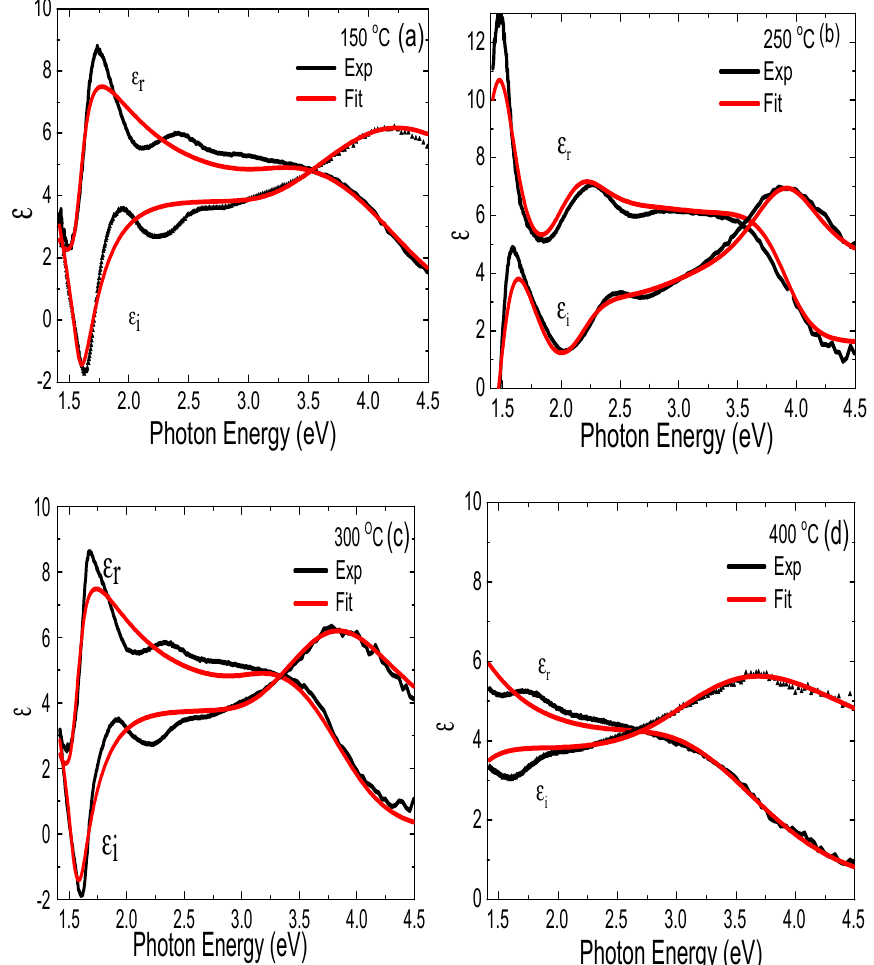
Figure 7. ( a – d ). The dielectric function ε r , ε i parameters vs. photon energy of CdSe thin films deposited at different growth temperatures. Table 2. Parameters extracted from spectroscopic ellipsometry.